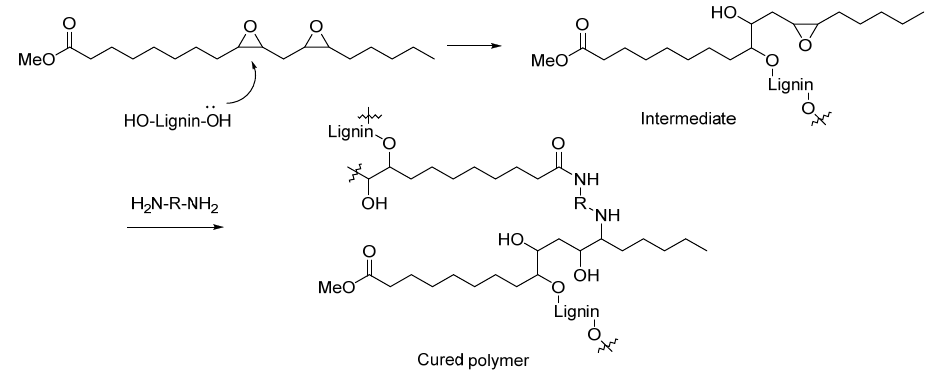
Table 3. Influence of the lignin content on the mechanical properties of the cured epoxy resins.